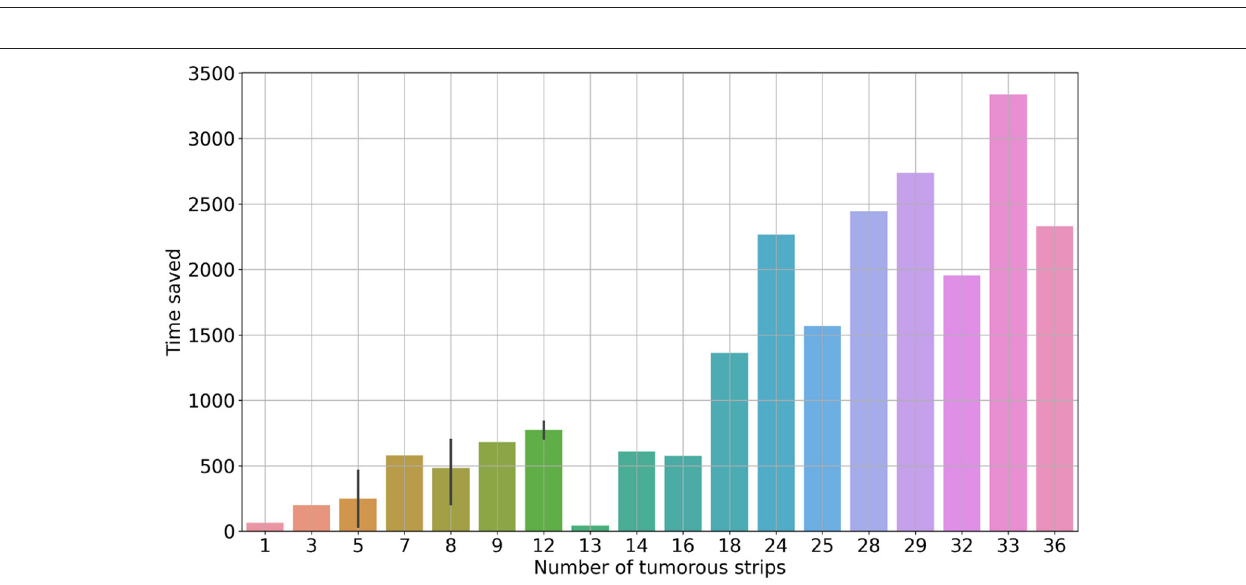
FIGURE 2 | The diagnostic time for cases with different numbers of tumorous strips.